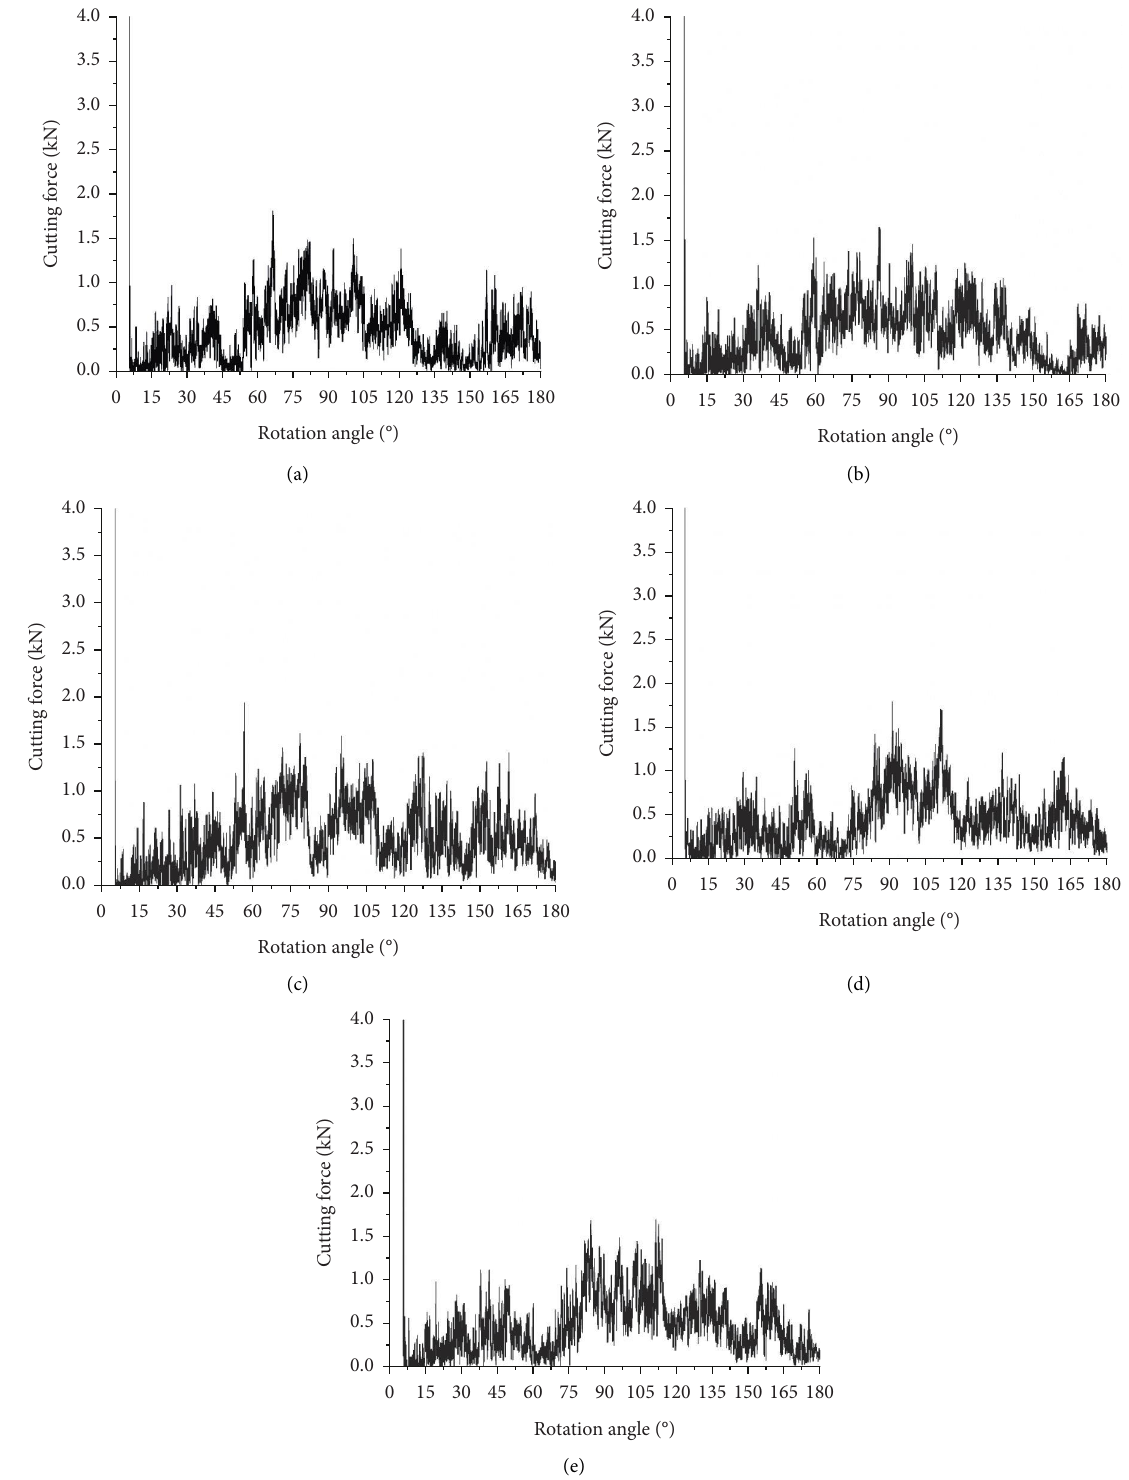
Figure 10: The cutting force with various cleat spacing of Figure